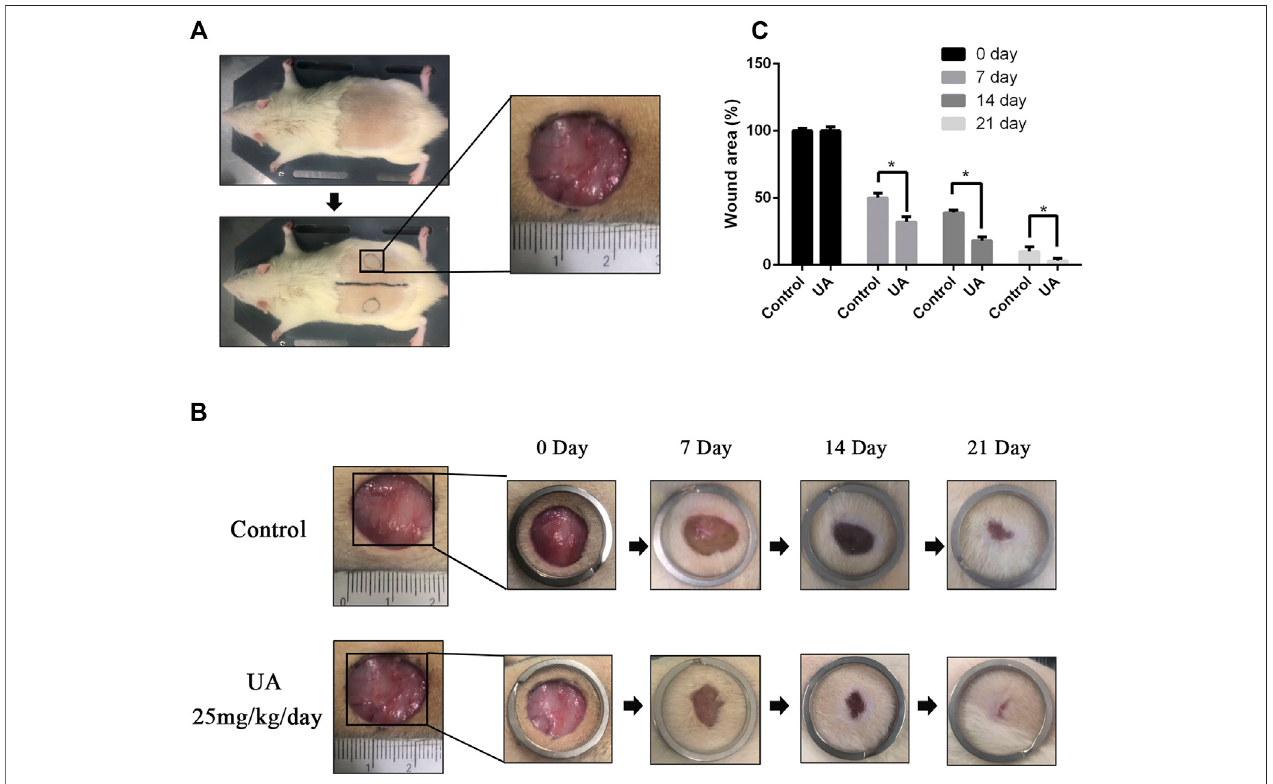
FIGURE4| UA promotes woundhealing invivo . (A) Arough photo ofthefull-thicknesswound model. (B) Representative images ofthewound-healingprocess of rats treated with UA at different time points. (C) Wound-healing rates at different times. The data represent mean ± SD ( n = 5) (* p < 0.05).